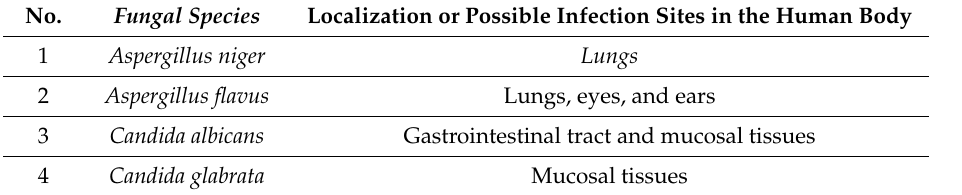
Table 8. Species of fungi used for the anti-fungal study.